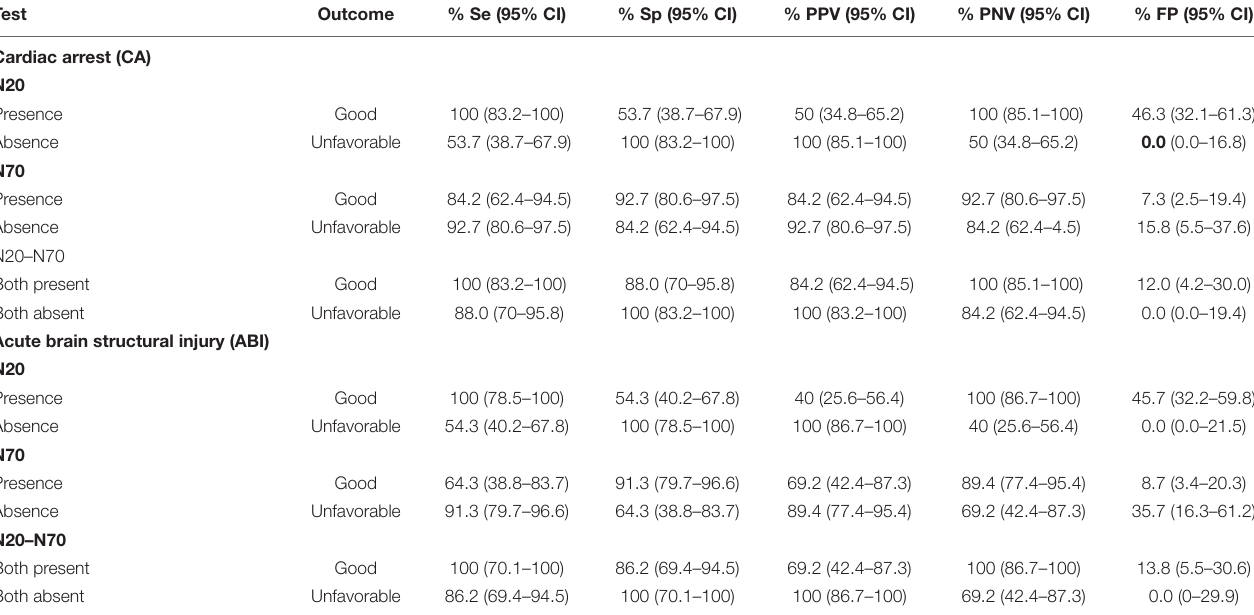
TABLE 2 | Diagnostic accuracy of somatosensory evoked potentials (SSEP) (N20 and N70) for long-term outcome prediction in patients with coma after cardiac arrest (CA) and after acute brain injury (ABI).